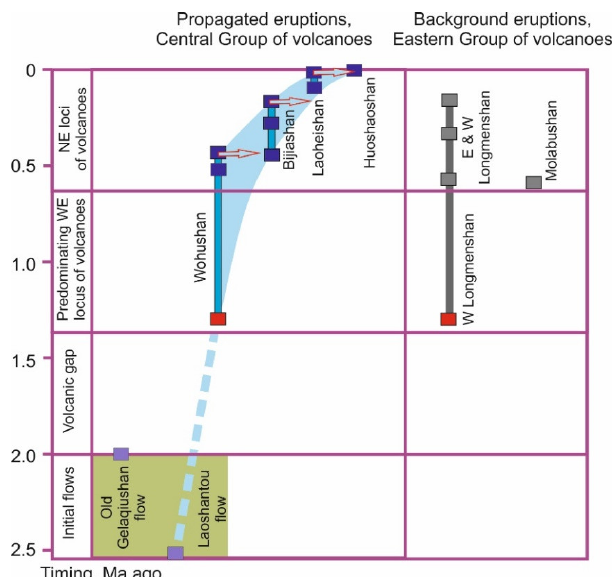
Figure 2. Activities of the Molabushan and Longmenshan volcanoes relative to a sequence of eruptions in the Central Group of volcanoes and older lava flows. A time range of the initial flows is highlighted by the green color. Propagated eruptions are designated with a blue stripe and red arrows. The scheme is modified after [32] using additional data [33] and references therein.